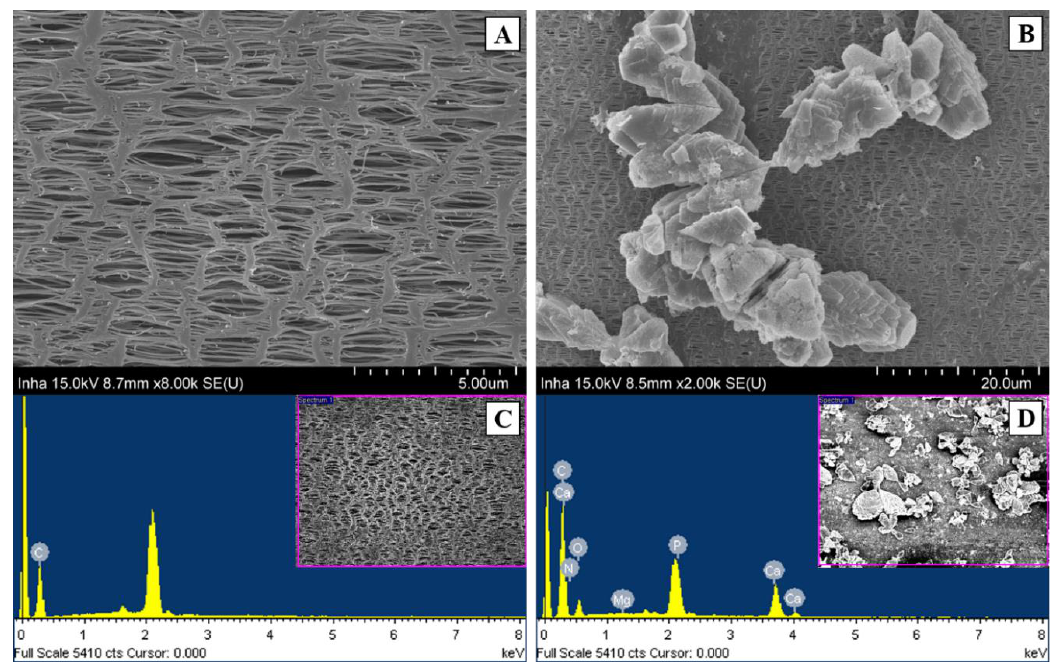
Figure 5. Variation of permeate flux ( A ) and mass transfer coefficients ( B ) in long-term operation.